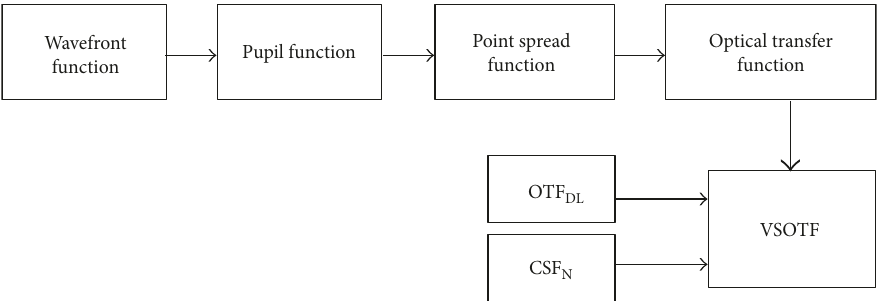
Figure 5: A schematic diagram of the custom algorithm written in